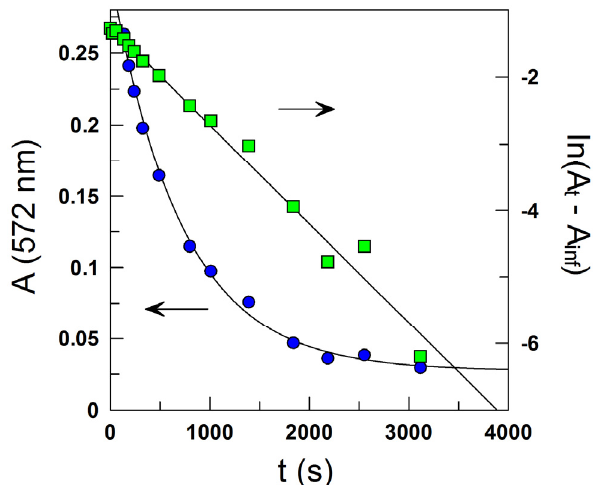
Figure 2. Typical kinetic plot illustrating the determination of k 16-ArN 2+ and RES in corn oil emulsions from the variation of the absorbance of the azo dye ( λ = 572 nm) with time (-  -) and ln plot (-  -), according to Equation (10). Reaction conditions: Ф (Tween 20) = 0.0289, [16-ArN 2+ ] = 1 × 10 − 4 M, [RES] = 1.3 mM, pH 2.14 I (0.04 M citric-citrate buffer), T = 25